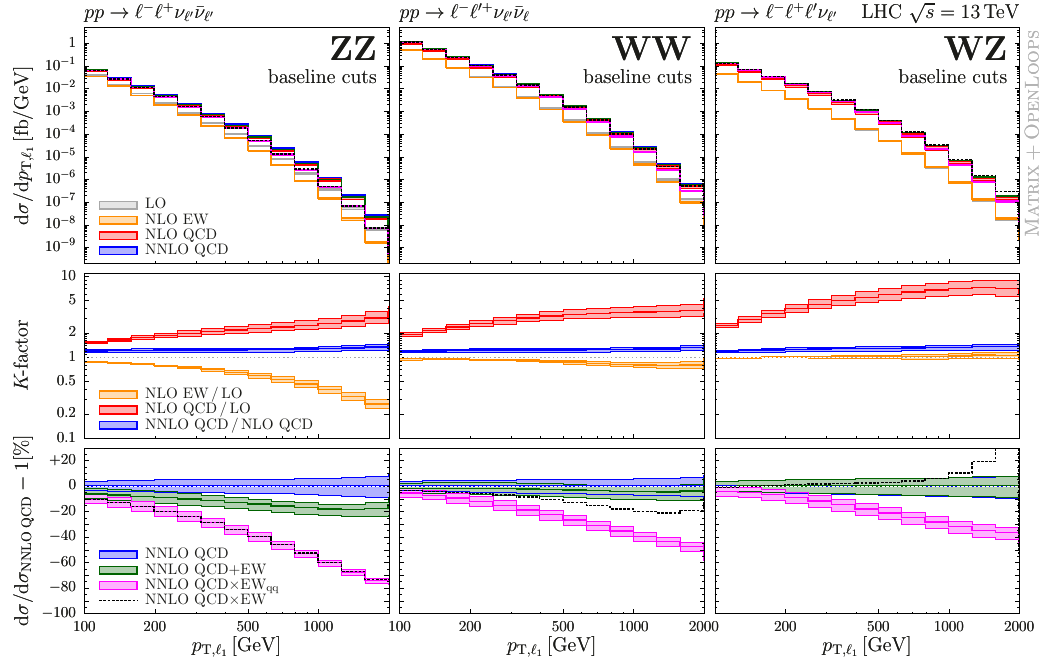
Figure 9 . Distribution in the transverse momentum of the hardest charged lepton for the pro- cesses (3.1){(3.3) at 13 TeV. Baseline cuts are applied without jet veto. Plot format and predictions as in (cid:12)gure